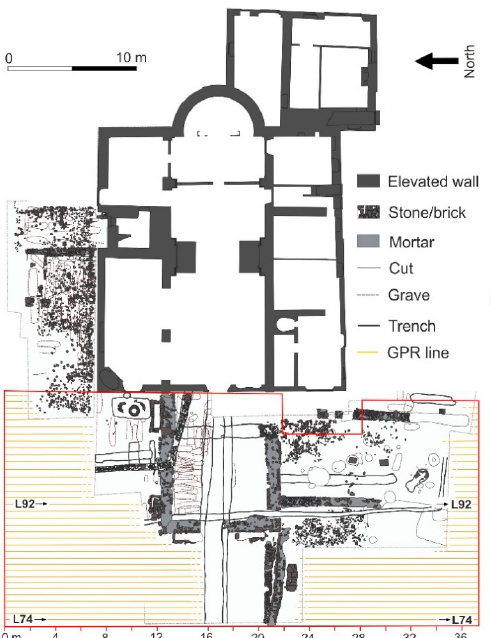
GPR, and the yellow lines are the traces of the GPR profiles (the codes correspond to GPR